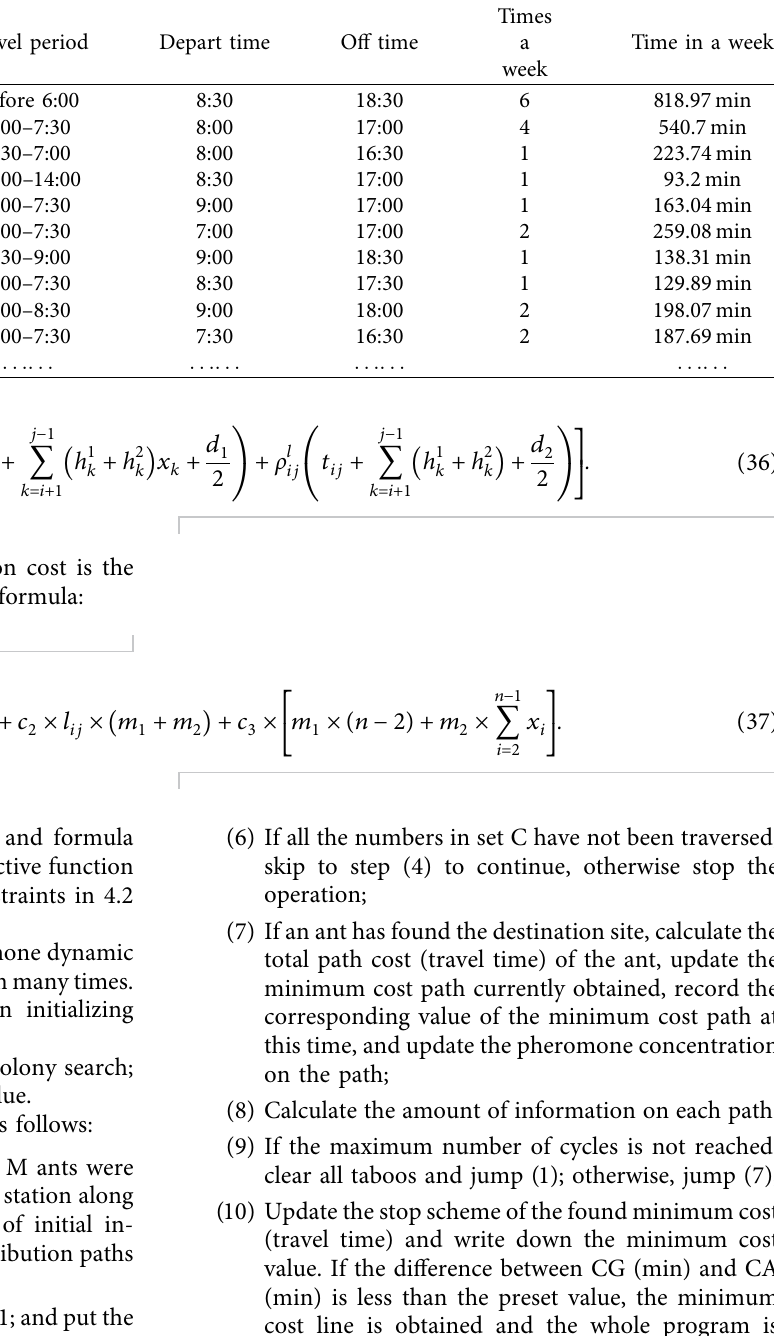
Table 2: Passenger fow time distribution of Shanghai rail transit line